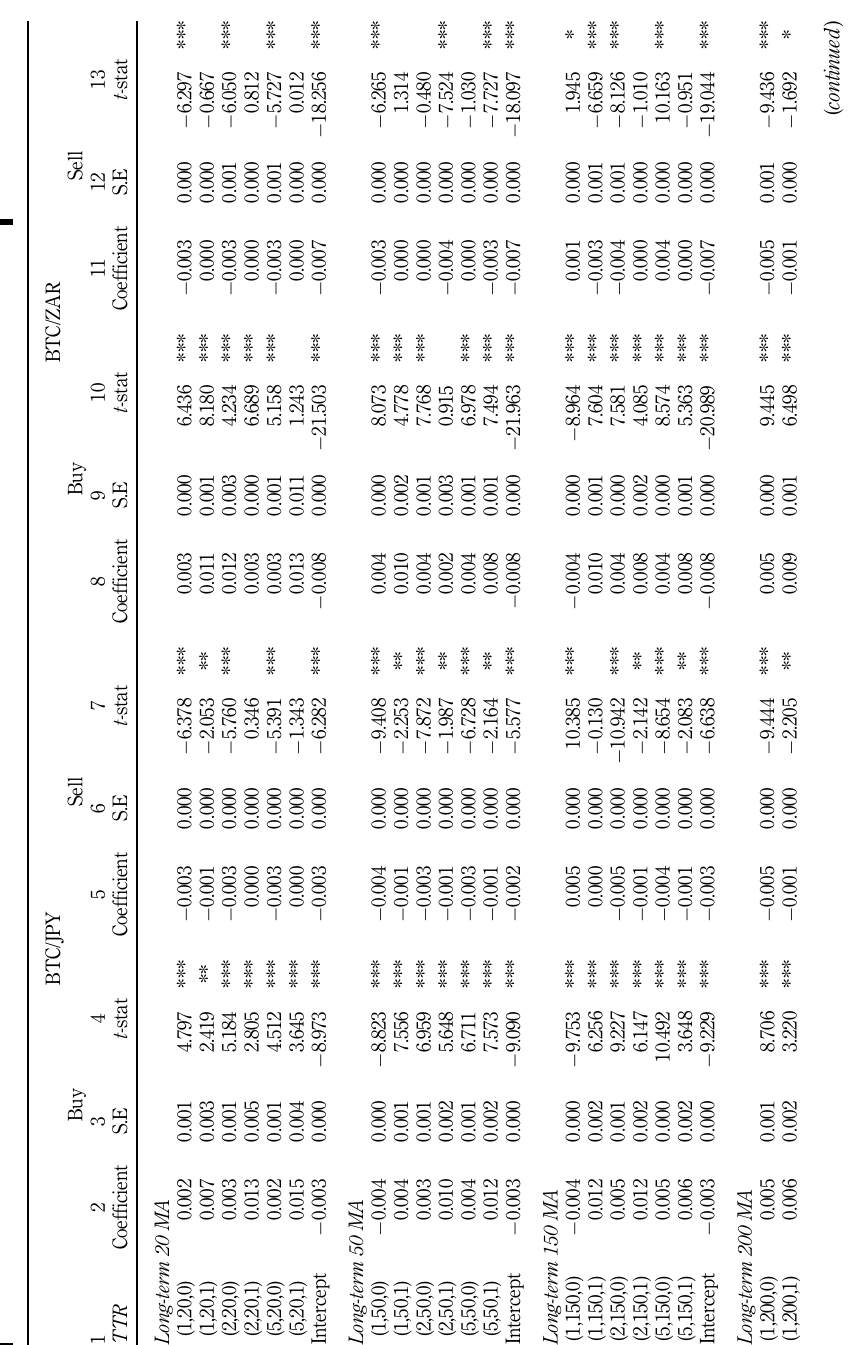
Table 9. Momentum